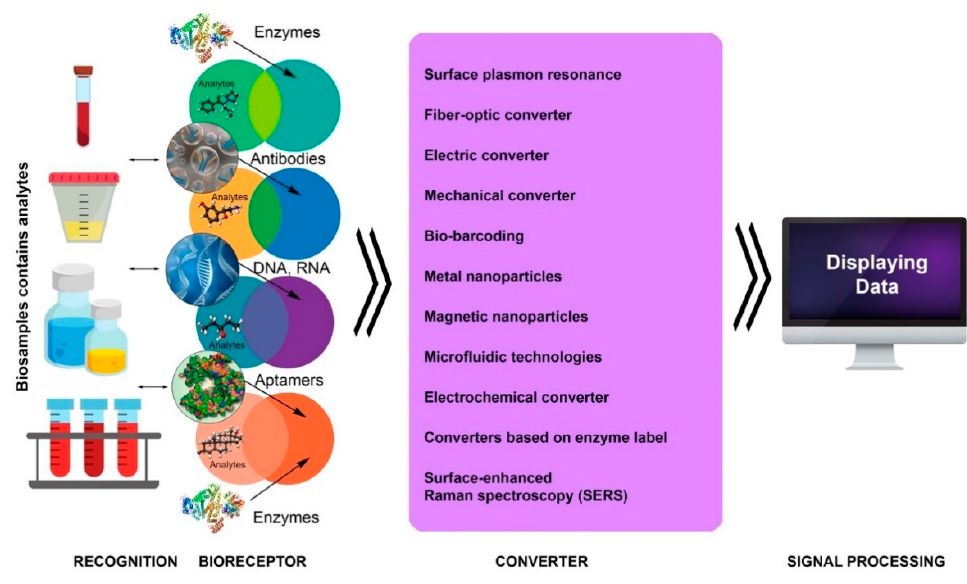
Figure 2. Schematic diagram of the structure of biosensors.